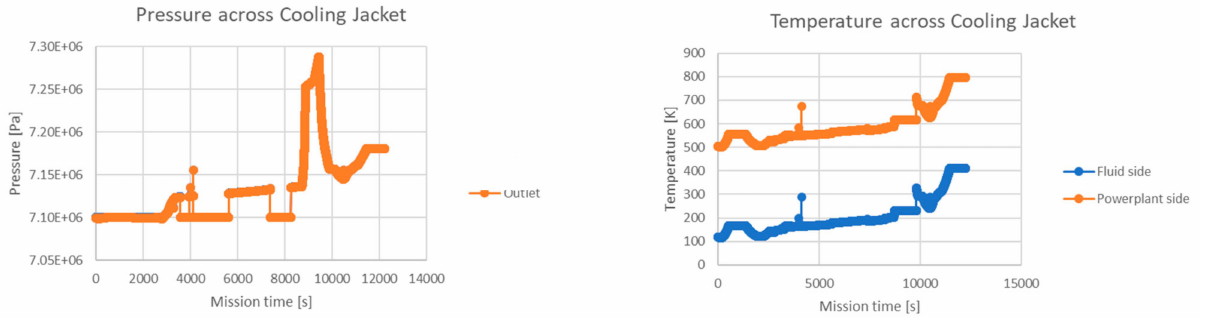
Figure 18. Pressure and temperature trends within the cooling jacket.